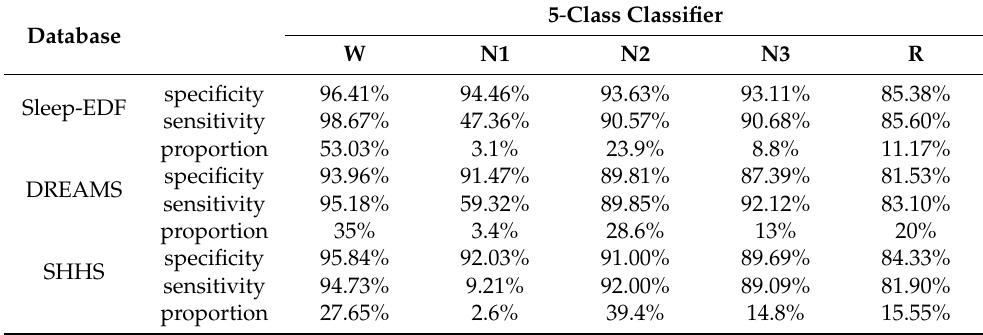
Table 5. The sensitivity, specificity, and proportion of each stage of 5-class classification.